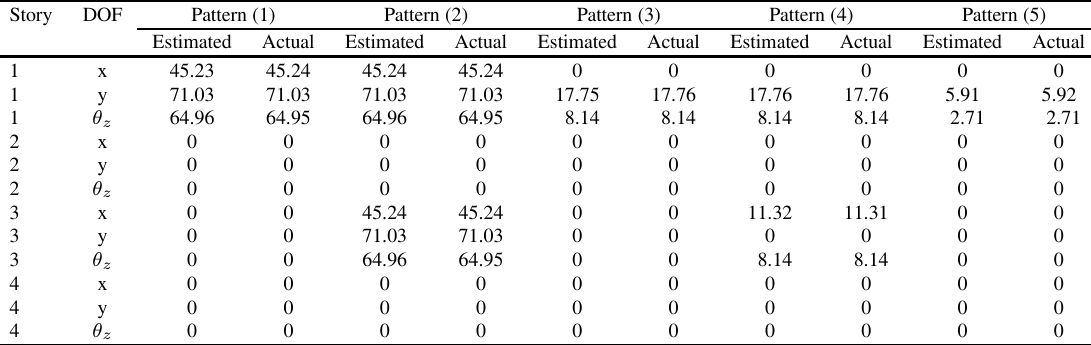
Table 2 The obtained results of damage detection for the benchmark structure (%)